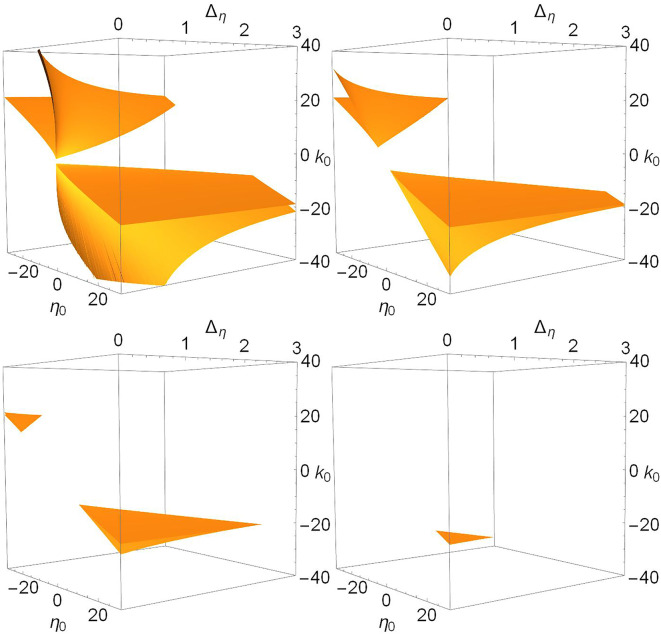
The saddle-node surfaces disappear from view as Δk increases. n = 2 and Δk = 0.0 (top left), 1.0 (top right), 2.0 (lower left), and 3.0 (lower right).